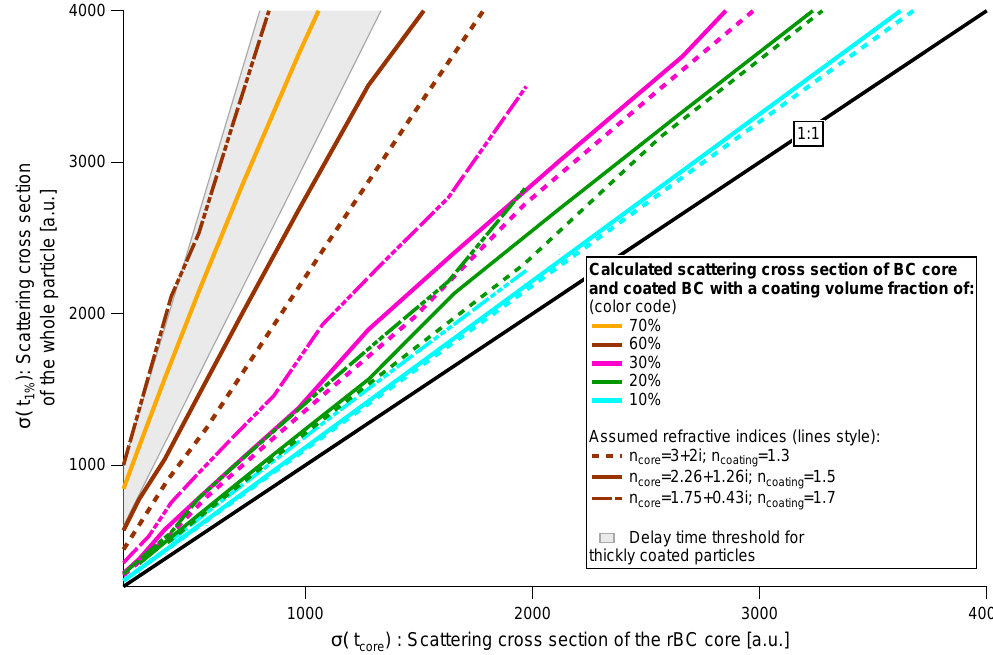
Fig. 2. Calculated scattering cross sections of the whole particle and the BC core. The scattering cross sections are calculated using Mie theory and assuming a concentric coated sphere morphology and different pairs of refractive indices (lines styles). The black line represents uncoated particles, independently of the refractive index, while the colored lines represent different coating volume fractions. The grey area represents the range of scattering cross section ratio for which the delay time threshold is reached (see Sect.